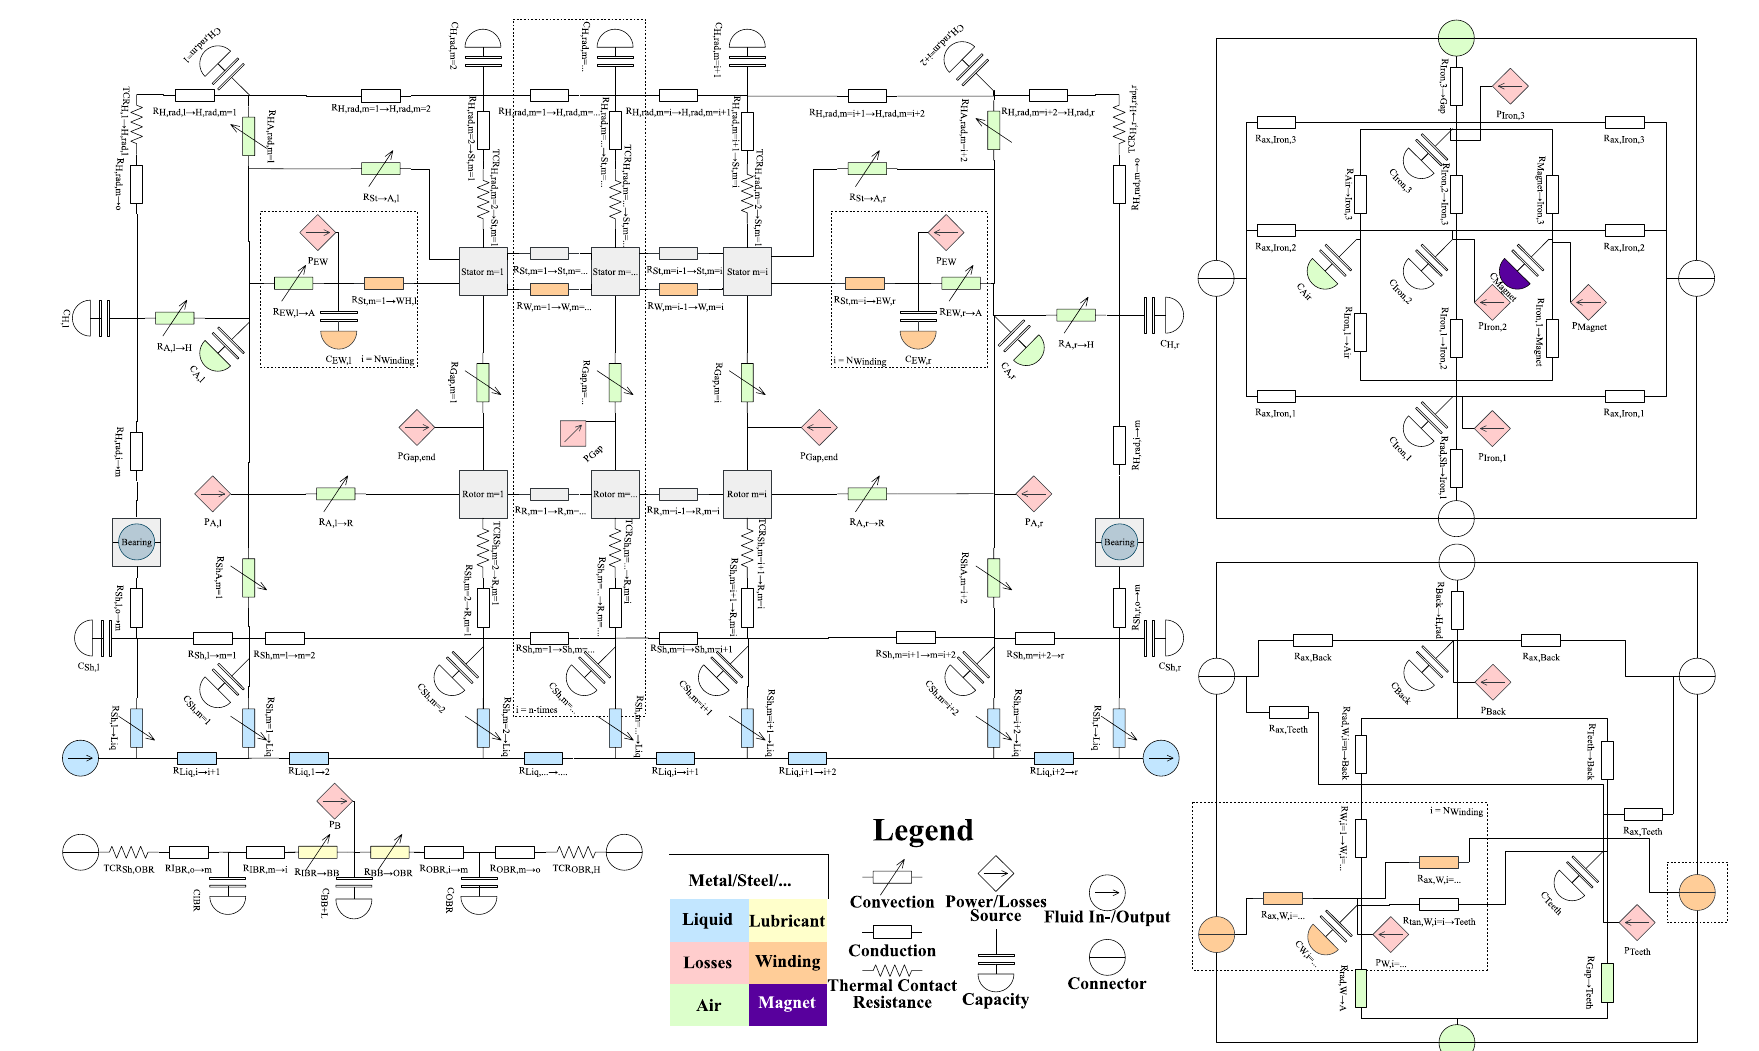
Figure 1. LPTN model with a direct cooled rotor shaft.